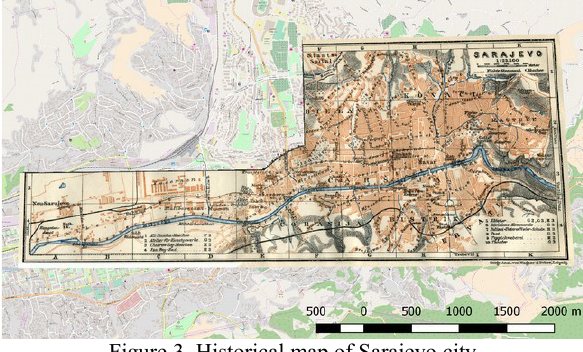
Figure 3. Historical map of Sarajevo city